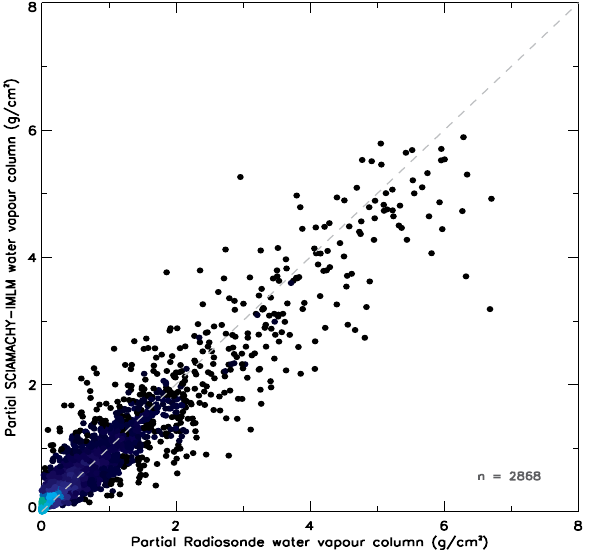
Fig. 14. Comparison between SCIAMACHY-IMLM partial WVC and radiosonde partial WVC amounts for measurement cases over the ocean where SPICI cloud fraction is larger than 0.2. The radiosonde partial WVC amounts are obtained by integrating the relative humidity profile from the cloud top pressure, calculated using the SCIAMACHY CH 4 column.